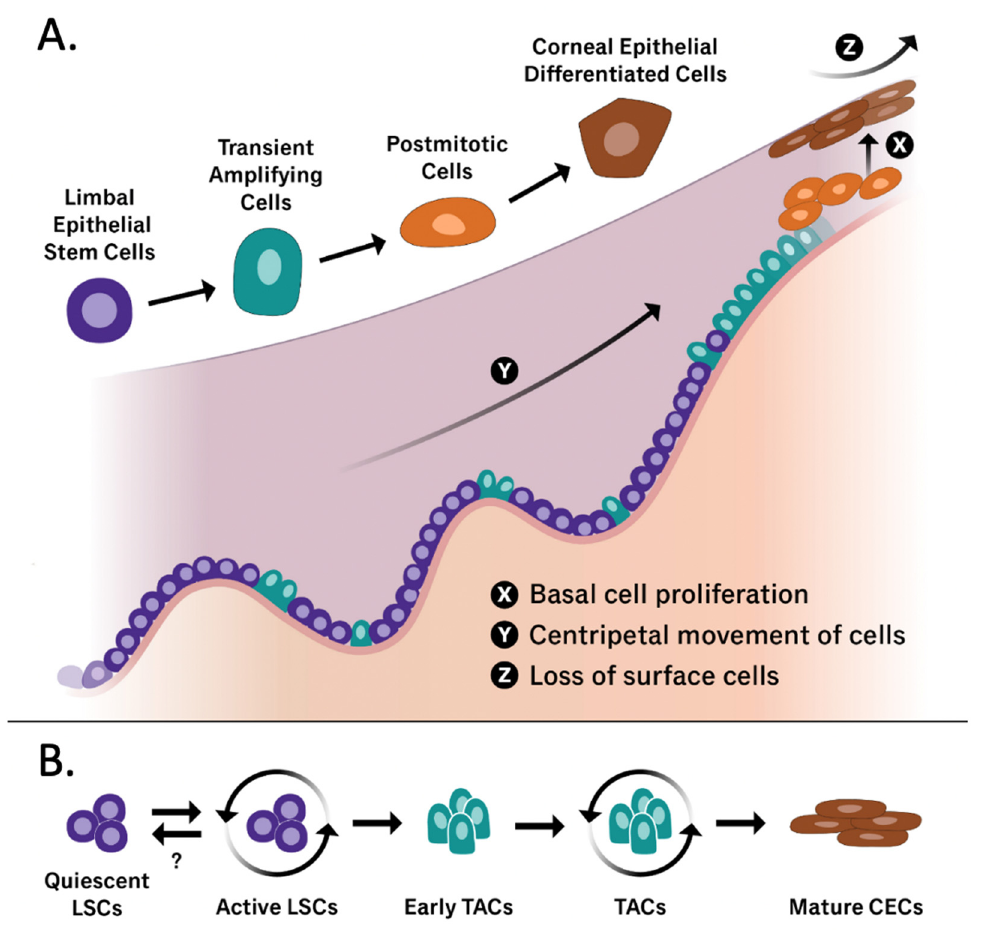
Figure 2. ( A ) Graphical representation of the limbal stem cell niche containing all cell states that have been implicated in corneal epithelium regeneration (LSCs, TACs, postmitotic cells, and corneal epithelial differentiated cells). The X, Y, Z hypothesis published by Thoft and Friend in 1983 [32] is also illustrated, including the three phenomena that allow the corneal epithelial cell mass to remain constant. X: proliferation of basal epithelial cells; Y: contribution to the cell mass by centripetal movement of peripheral cells; Z: epithelial cell loss or constant desquamation from the surface. ( B ) A graphical representation of the differentiation of quiescent limbal stem cells into mature corneal epithelial cells. While the triggers that drive quiescent LSCs into an active differentiating phenotype are well documented, further exploration in reversing this process is warranted. Adapted from [33,34]. The fate of plastic LSCs is determined through complex interplay between LSCs and their niche. Within their microenvironment, LSCs are exposed to a multitude of inputs including molecular signaling and mechanotransduction events [35]. The cellular popula- tions of the LSC niche are varied and include mesenchymal cells, melanocytes, immune cells, vascular cells, and nerve cells [12]. The presence of specific extracellular matrix that altered ECM interactions may influence LSC phenotype and homeostasis [36]. In their